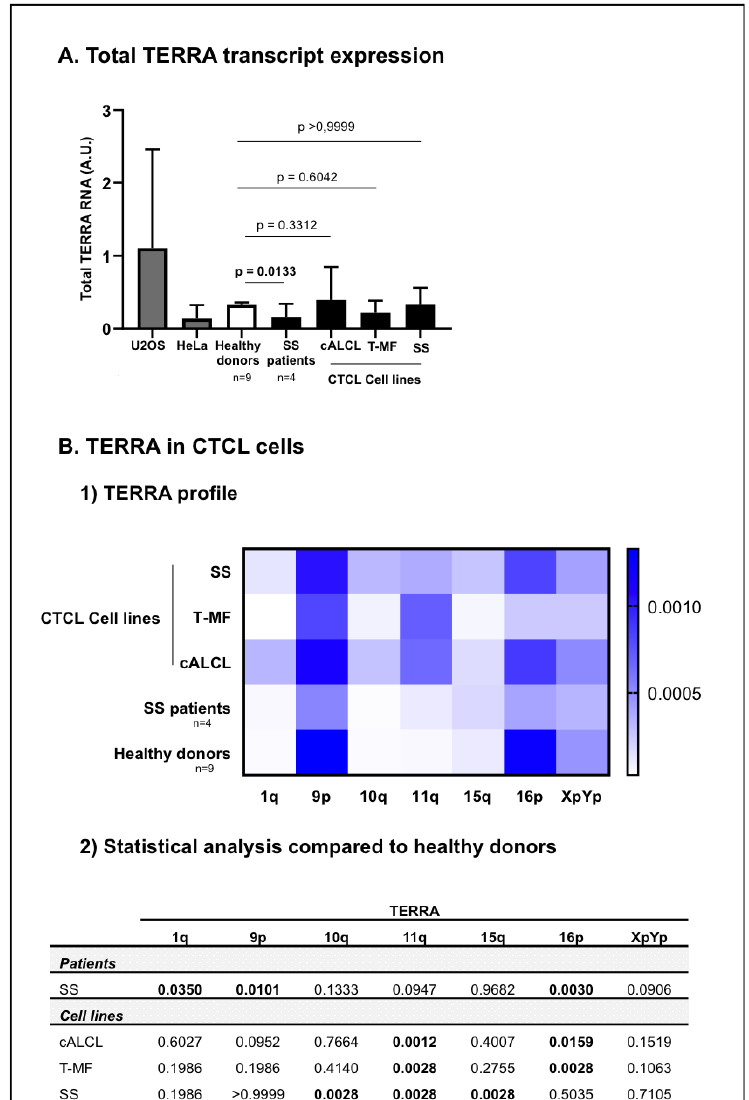
Figure 2. Telomeric repeat containing RNA (TERRA) in CTCL cells. TERRA from chromosome ends 1q, 9p, 10q, 11q, 15q, 16p and XpYp were analysed in CTCL cells, including SS patients (n = 4) and CTCL cell lines representative of different CTCL subtypes: c-ALCL, T-MF, and SS), and then compared with healthy donors (n = 9). ( A ) The total TERRA expression was evaluated. Before the analysis of our cells of interest, the RT-qPCR protocol for quantification of TERRA was validated in HeLa and U2OS cell lines (in grey). We confirmed that U2OS and HeLa cells express different TERRA levels [56]. Data are expressed as mean ± SD. ( B ) For CTCL cells we presented the (1) TERRA profile for seven telomeric transcripts in a heat map: horizontal axis = TERRA transcripts; vertical axis = cells analysed. Low expression levels are displayed in light blue, and high expression levels in dark blue. (2) Statistical analysis from TERRA profiling. Significance level: p =